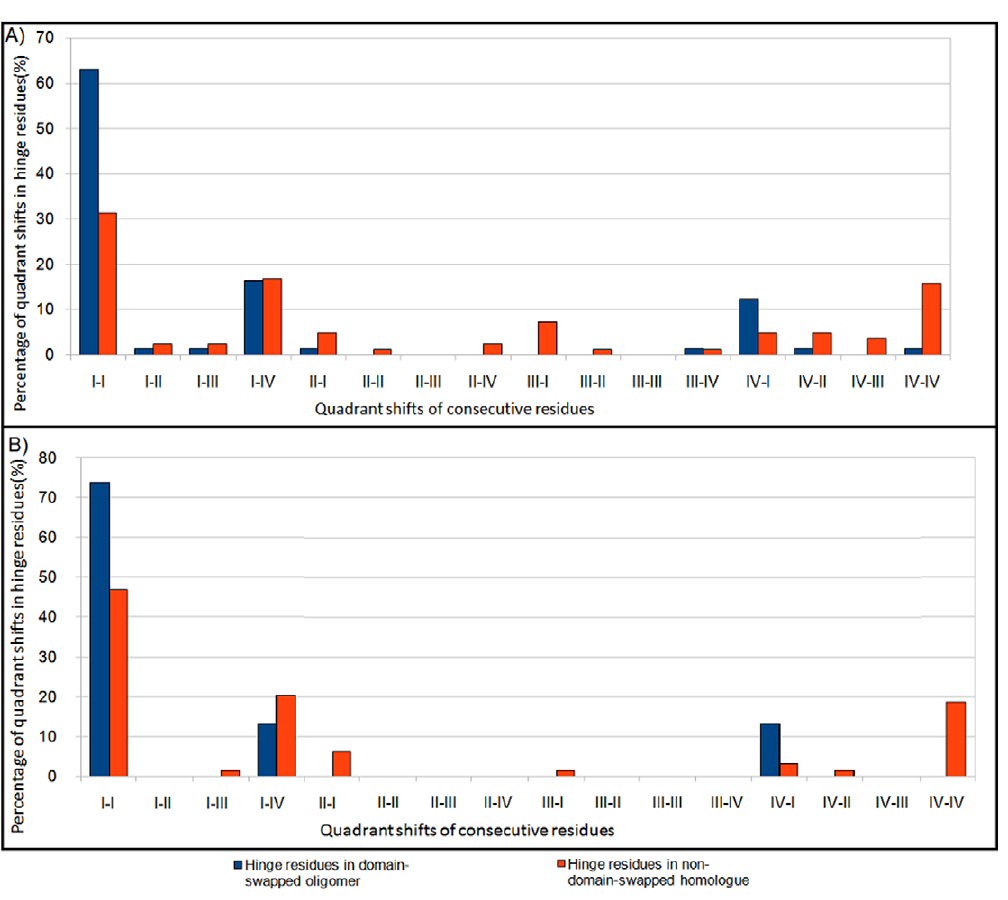
Figure 6. Conformation of residues in hinge region for domain-swapped structure and non-domain swapped homologue. A) Percent distribution of quadrant shifts of all hinge residues. B) Percent distribution of quadrant shifts of non-glycine hinge residues. doi:10.1371/journal.pone.0039305.g006 suggests side-chains of residues in DSI were approximately five times more protruded outside compared to residues in NDSI.